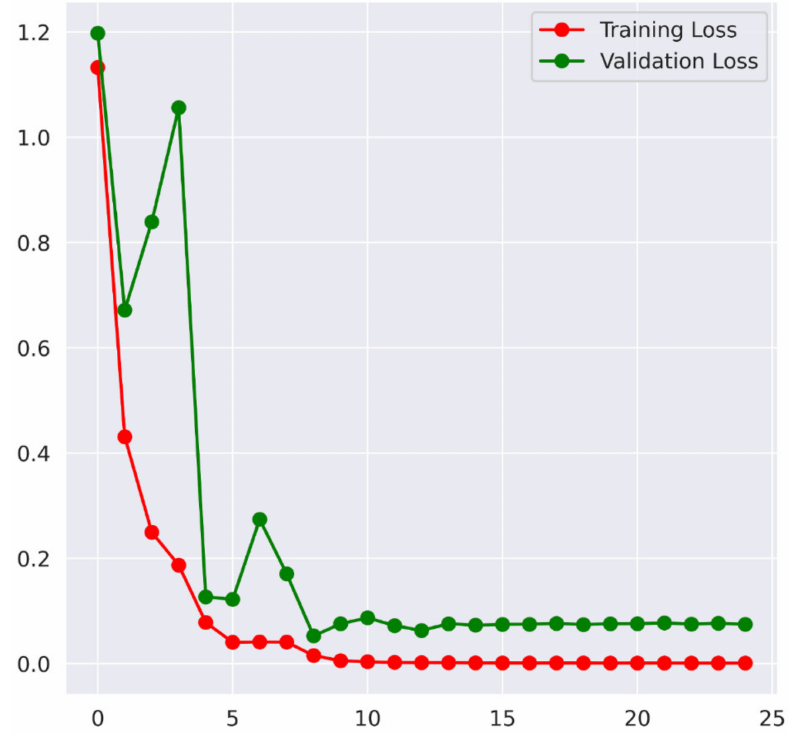
Figure 8. Training and testing losses for protocol-II.